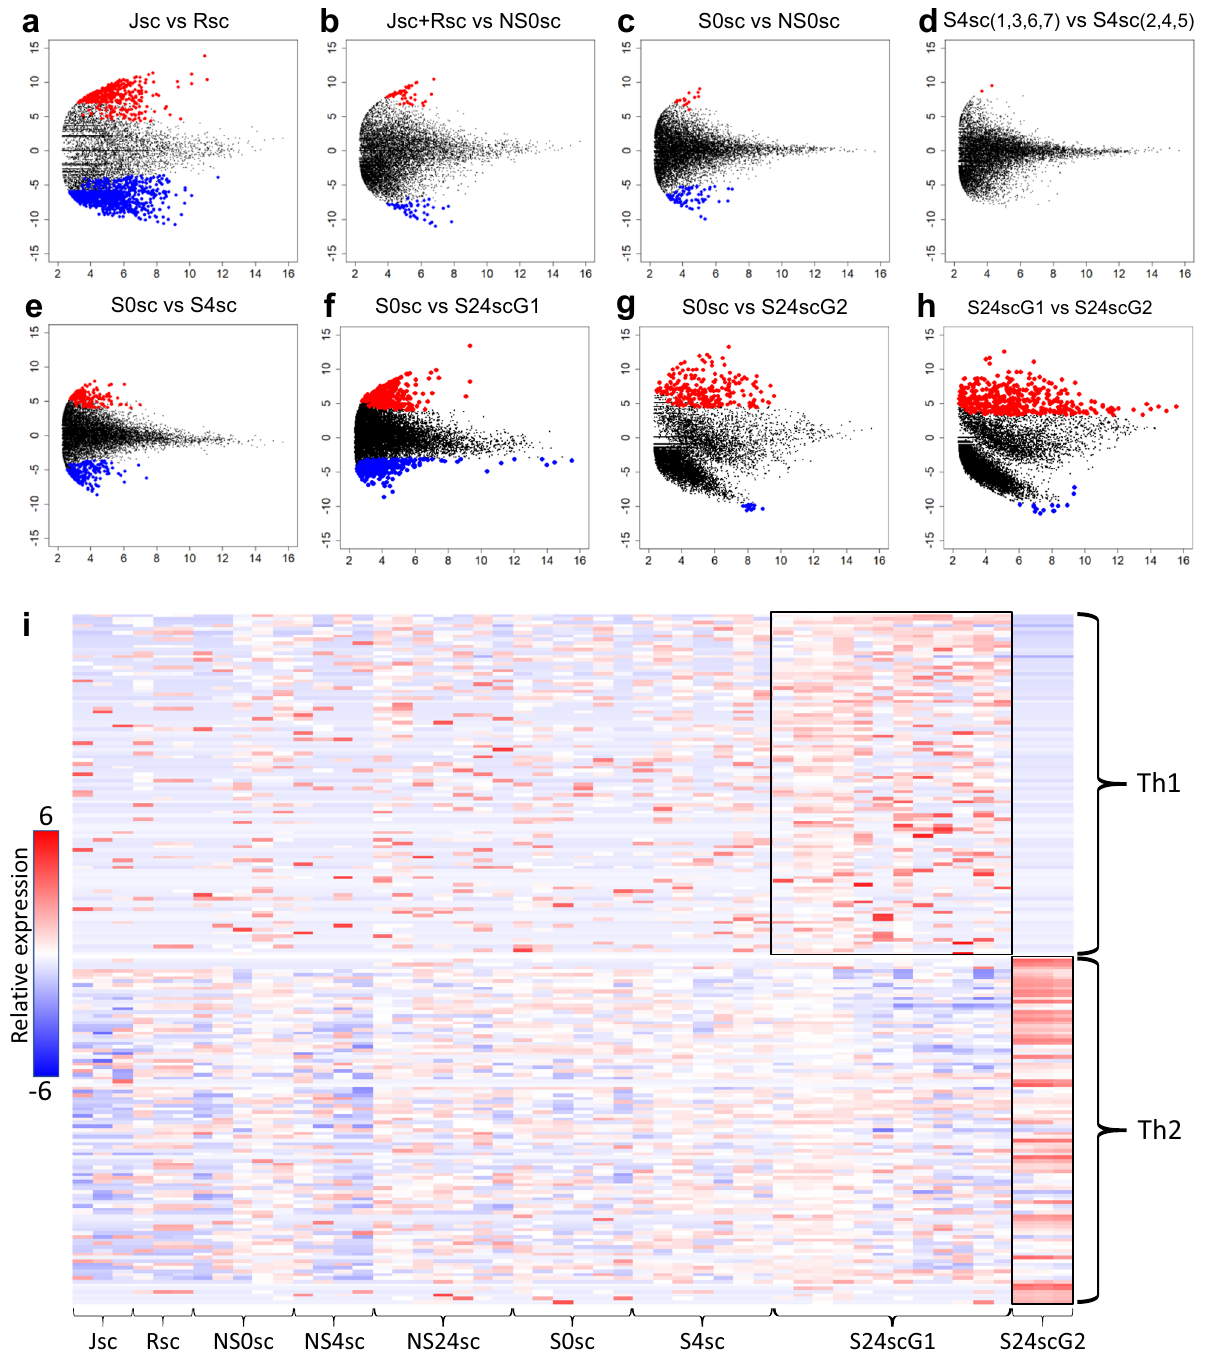
Fig. 4 Differential gene expression data on Jurkat-Raji immunological synapse cell pairs and controls. a – h Mean-Divergence plots comparing transcriptomes from Jurkat single cells (Jsc); Raji single cells (Rsc); synapsing cell pairs at 0, 4, and 24 h (S0sc, S4sc, S24sc); non-synapsing cell pairs at 0, 4, and 24 h (NS0sc, NS4sc, NS24sc). X-axis shows average log-CPM (counts per million). Y-axis shows log-fold-change between tested groups. Highlights indicate upregulated (red) and downregulated (blue) genes with p < 0.05. a Jsc vs. Rsc. b Concatenated Jsc and Rsc transcriptomes vs. NS0sc. c S0sc vs. NS0sc. d Comparing two randomly selected groups of S4sc. e S0sc vs. S4sc. f S0sc vs. synapse at 24 h group 1 (S24scG1). g S0sc vs. synapse at 24 h group 2 (S24scG2). h S24scG1 vs. S24scG2. i Heatmap showing log-CPM of putative genes for T helper cell type 1 (Th1) and type 2 At 24 h post-synapse, we found dramatically different gene expression pro fi les with 465 upregulated and 551 downregulated genes compared to the synapse gene expression pro fi le at 0 h (S24sc vs. S0sc, Fig. 4f, g and Supplementary Fig. S3g, h). To compare gene expression between cells at 24 h, we fi tted a linear model to the expression of genes by each cell pair and we calculated the Pearson